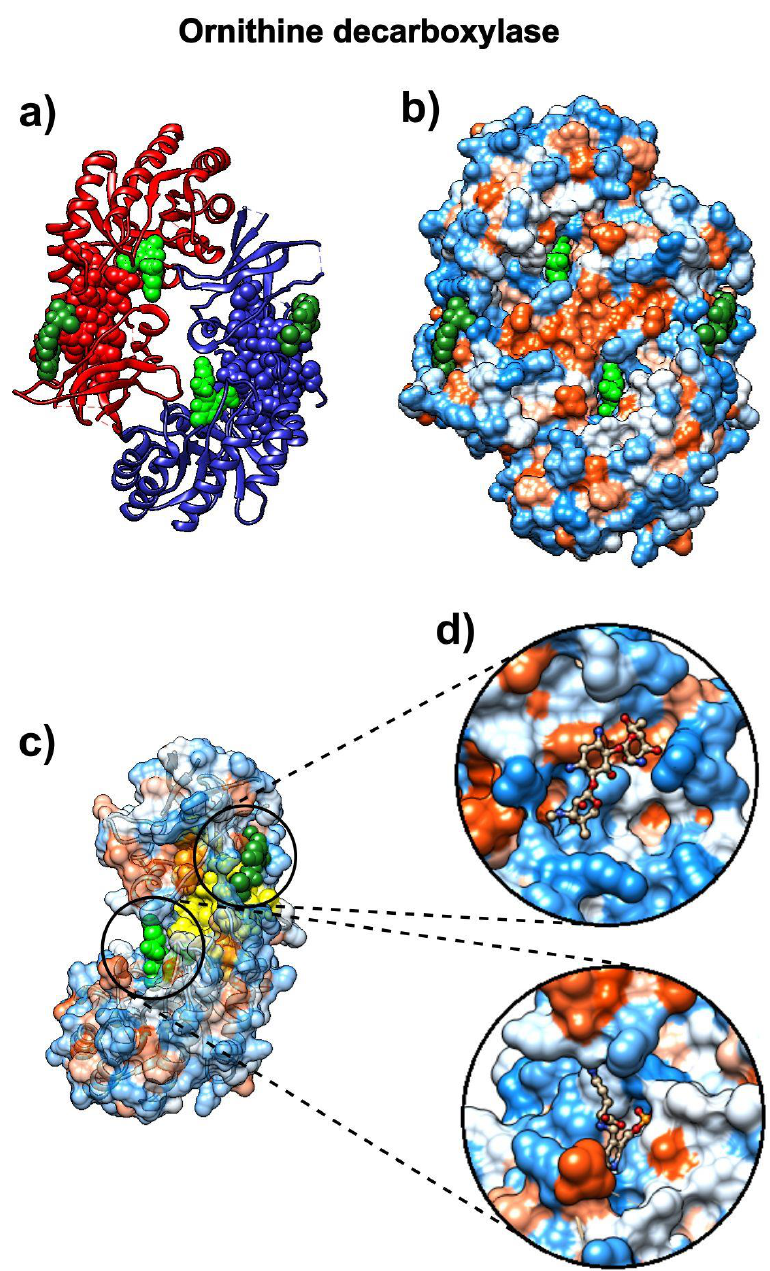
Figure 7. D-ornithine and its target protein Trypanosoma brucei ornithine decarboxylase (pdb id 1njj). ( a ) Ornithine decarboxylase chains A (red) and B (blue) are depicted as ribbons, with D-ornithine and G-418 as green and dark green molecules, respectively. ( b ) Ornithine decarboxylase chains A and B are depicted as hydrophobicity surface, with D-ornithine and G-418 as green and dark green molecules, respectively. ( c ) Ornithine decarboxylase chain A depicted as a transparent hydrophobicity surface, with SAGNM predictions are yellow atoms, and with D-ornithine and G-418 as green and dark green molecules. ( d ) D-ornithine and G-418 molecules depicted as colored bonds and sticks, correspondingly to the atom type and inside pockets on the surface of ornithine decarboxylase.